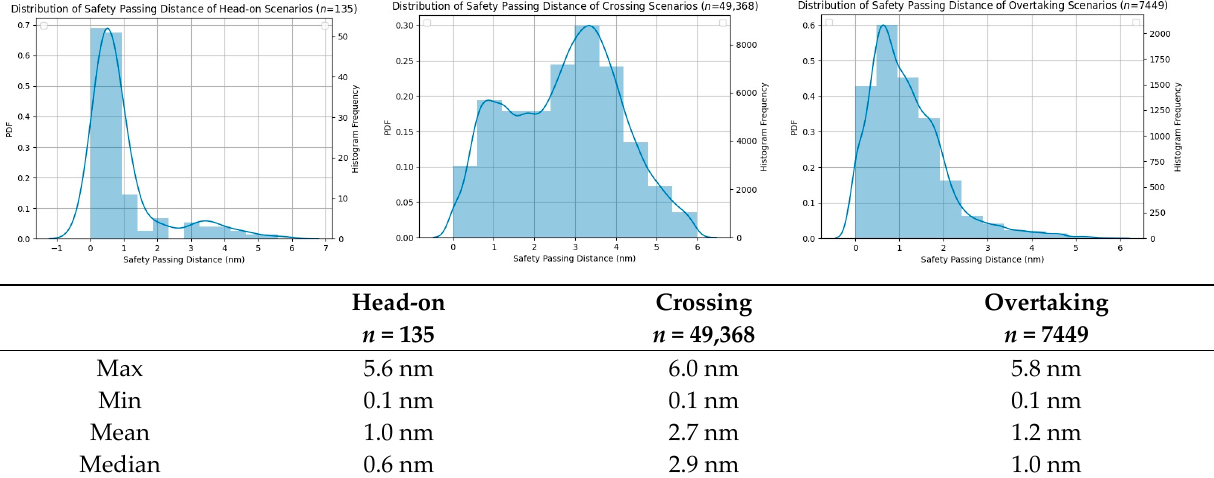
Figure 9. Distribution of safety passing distance of different encounter scenarios. The numbers indicate the minimum relative distance between OS and TS during encounter scenarios.